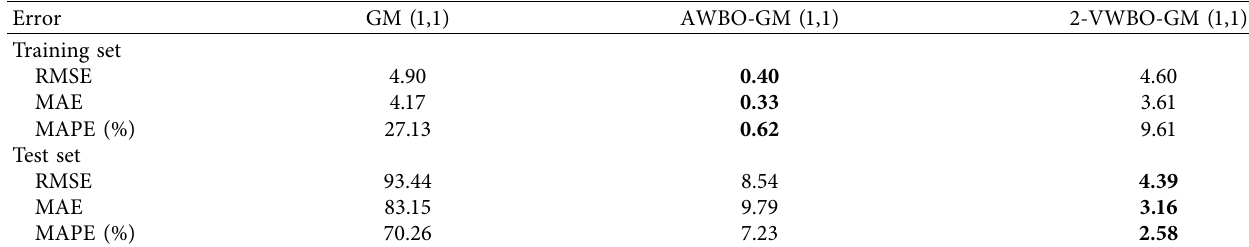
Table 4: Computational results of each evaluation metric in case